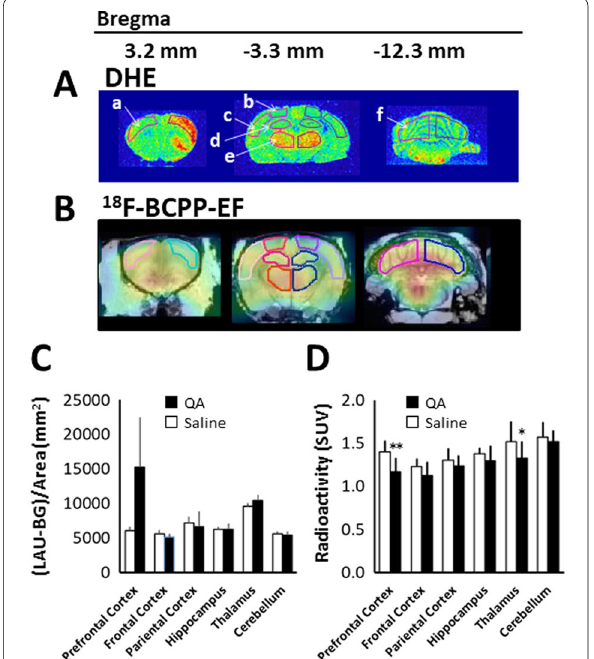
Fig. 4 DHE and 18 F-BCPP-EF uptake in various brain regions 24 h after QA injection. QA was injected into the striatum on the right side of the image, and saline was simultaneously injected into the contralateral striatum. A The accumulation of fluorescence in the QA-injected striatum 60 min after the intravenous injection of DHE.